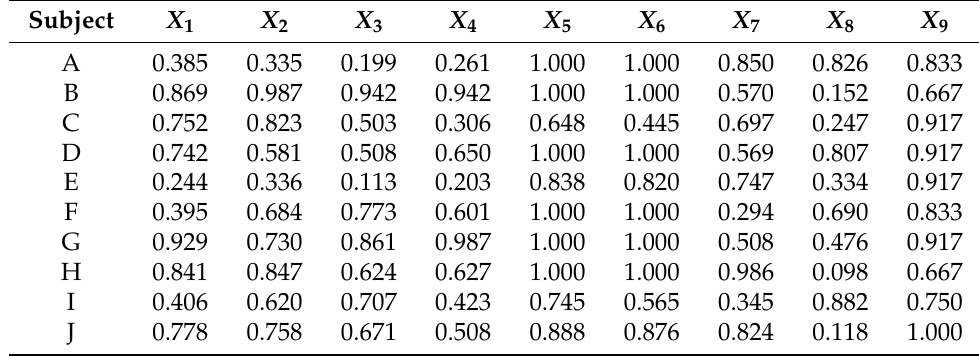
Table 6. Results of the input features from squat measurement ( X 1 to X 9 ) for 10 subjects.